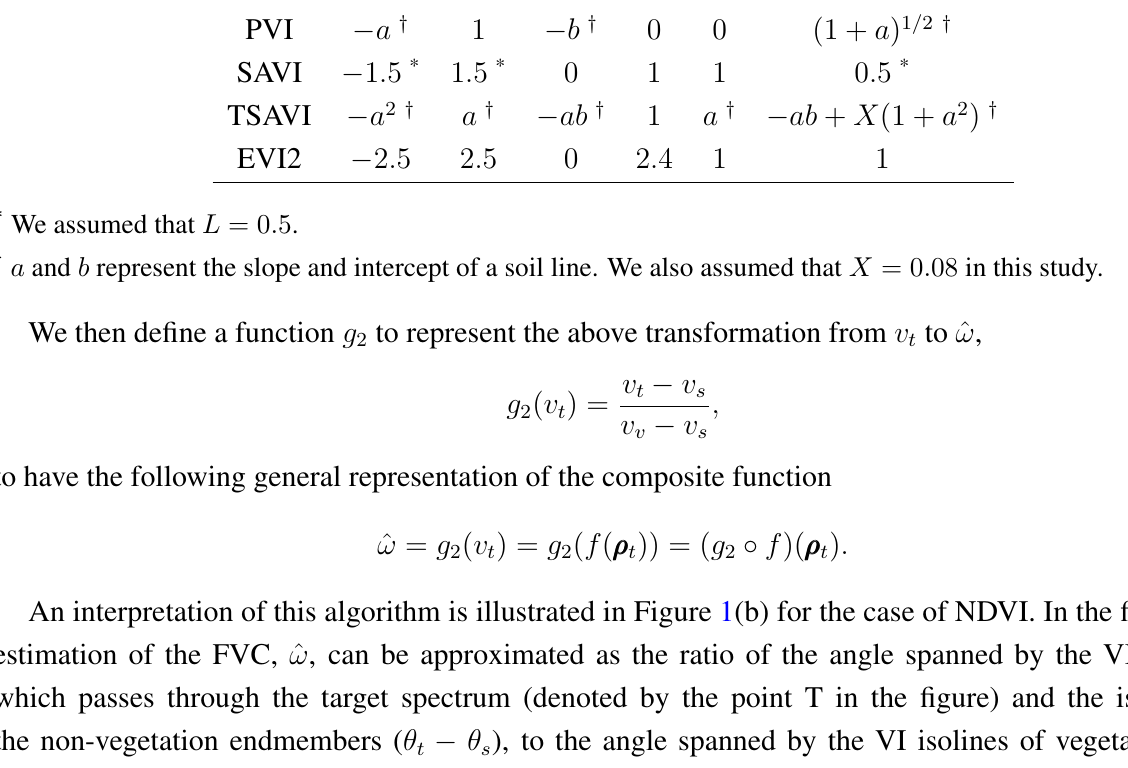
Table 1 . Coefficients of two-band VIs ( p